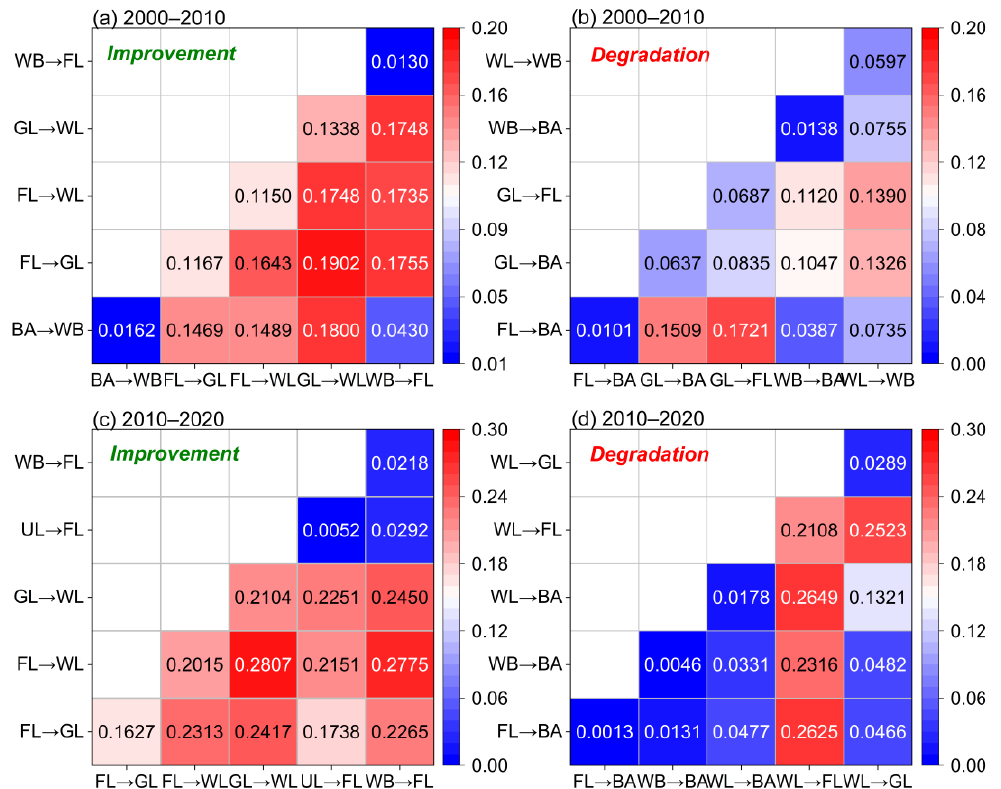
Figure 13. Interaction detection results of drivers of ecological quality changes from 2000 to 2020: ( a , b ) are the interaction detection results of drivers of ecological quality improvement and degradation from 2000 to 2010, respectively; ( c , d ) are the interaction detection results of drivers of ecological quality improvement and degradation from 2010 to 2020, respectively. The redder color indicates the stronger interaction between the two factors, and the bluer color indicates the weaker interaction between the two factors.